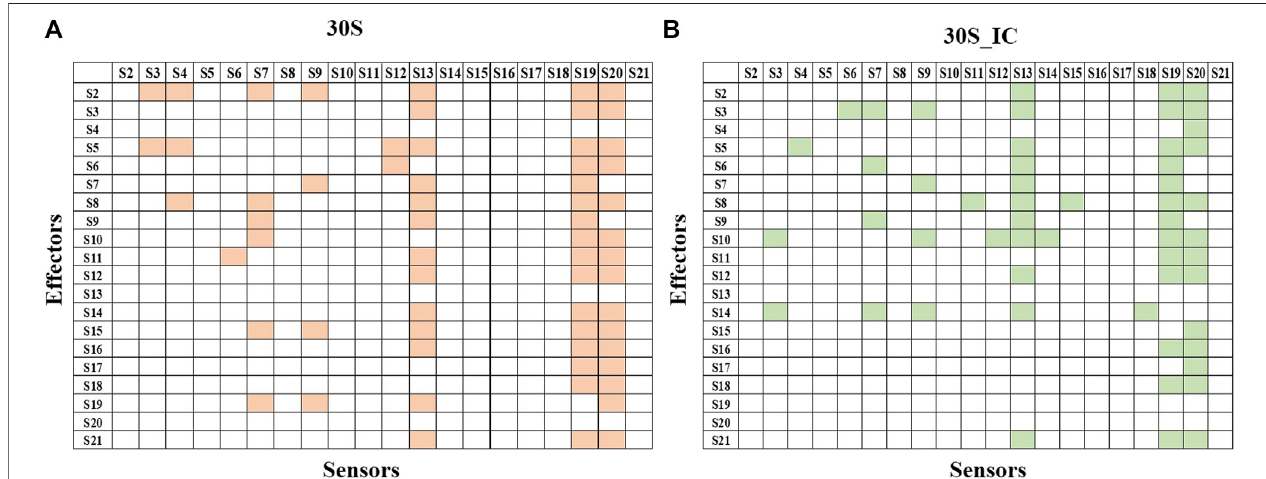
FIGURE3| Protein-proteininteractionnetworkof30Sand30S_IC.Protein-proteininteractionnetworkwasbuiltbasedonthedataobtainedfromPRSoftheentire complexes. If perturbation of a residue affects a residue from another subunit, then they were represented as interacting pair. Binding of mRNA along with IFs changes the protein interaction network of 30S complex. (A) Subunit interaction network of 30S complex is shown in the 2X2 matrix. Presence of interaction between any two proteincomponentsisshowninorange.Absenceofinteractionisindicatedbyablankcell. (B) Subunitinteractionnetworkof30Sinitiationcomplexisshowninthe 2X2 matrix. Here, as in (A) presence of interaction is shown in